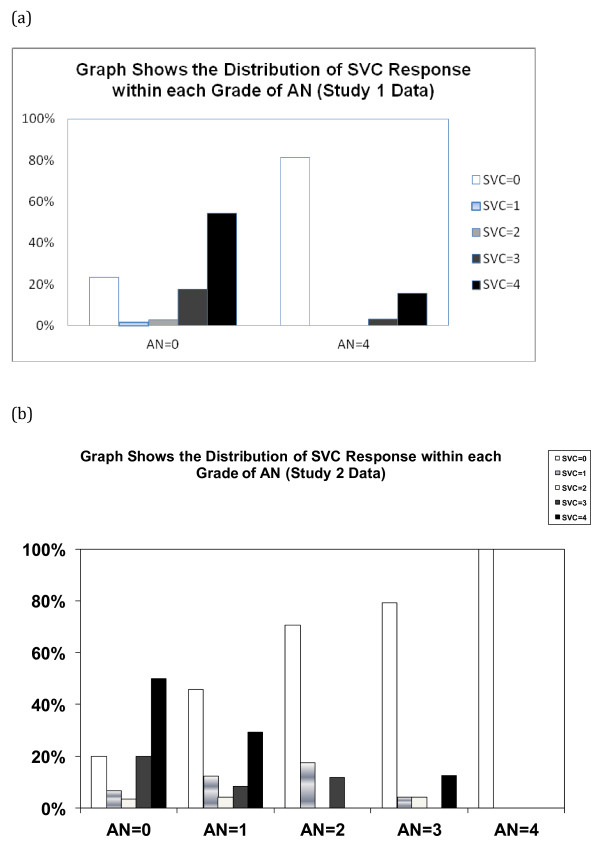
(a) Graph Shows the Distribution of SVC Response within each Grade of AN (Study 1 Data). (b) Graph Shows the Distribution of SVC Response within each Grade of AN (Study 2 Data).